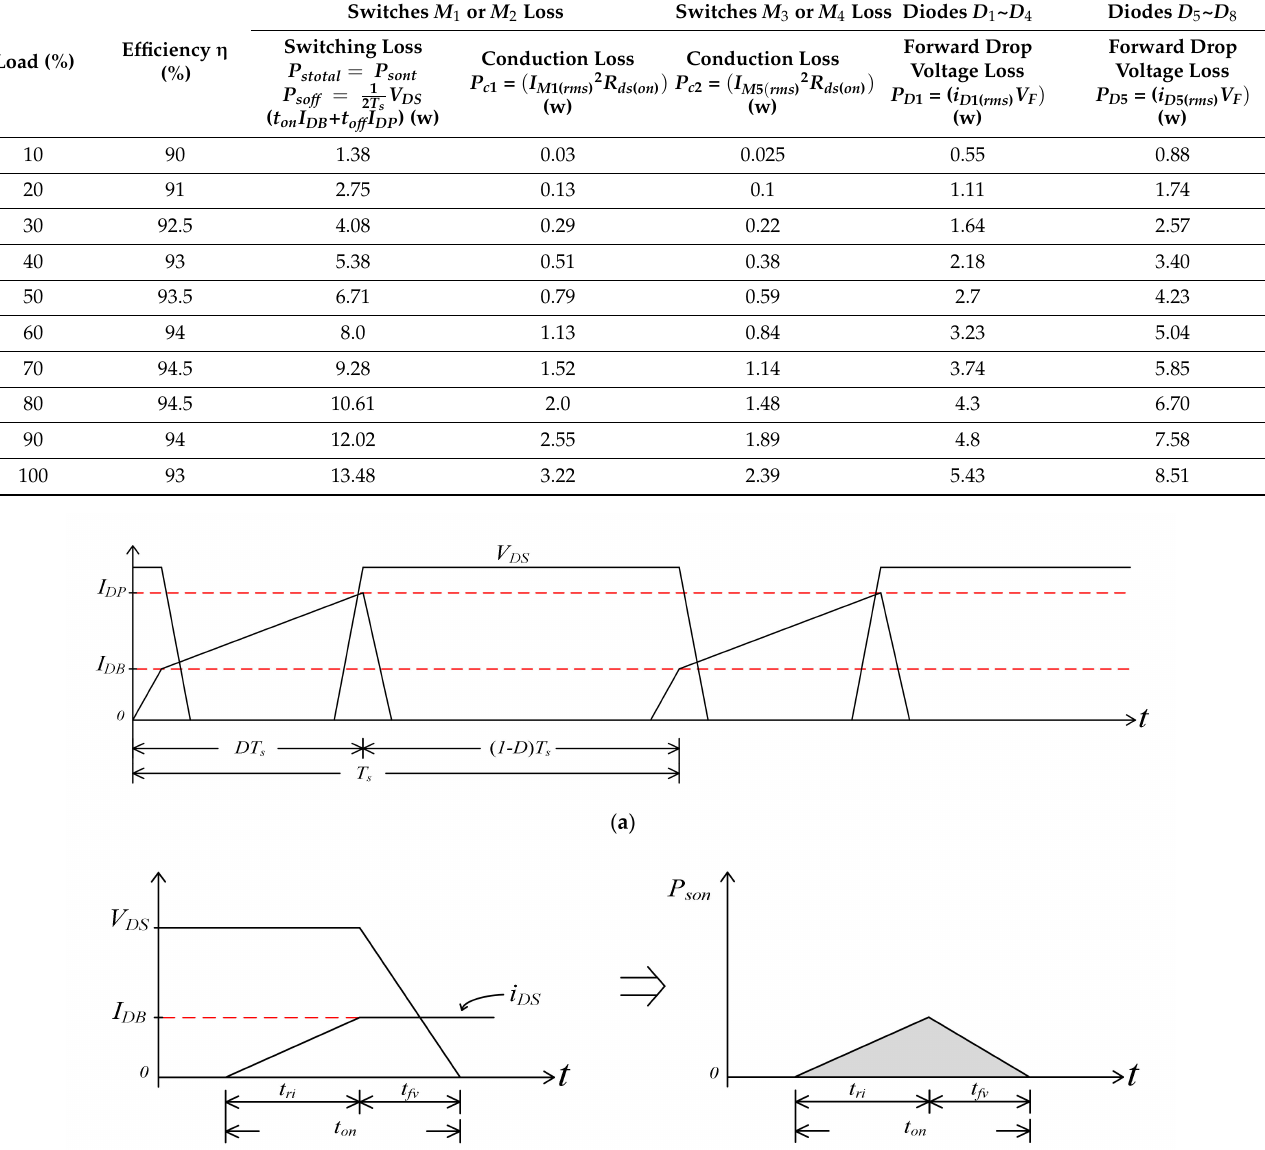
Table 4. Semiconductor loss analysis for the proposed boost converter under input voltage of AC 100 V.